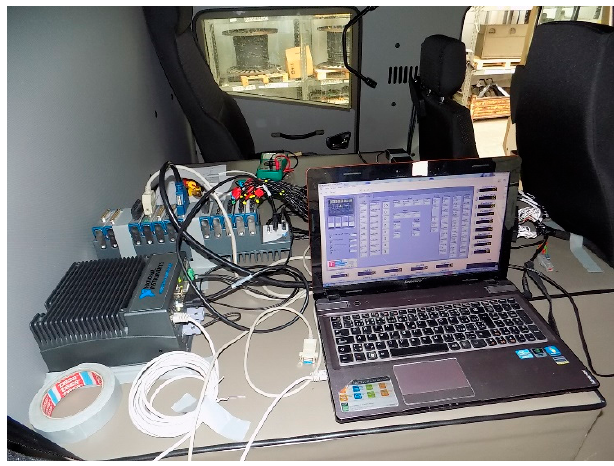
Figure 4. The hardware used for testing in the prototype vehicle.